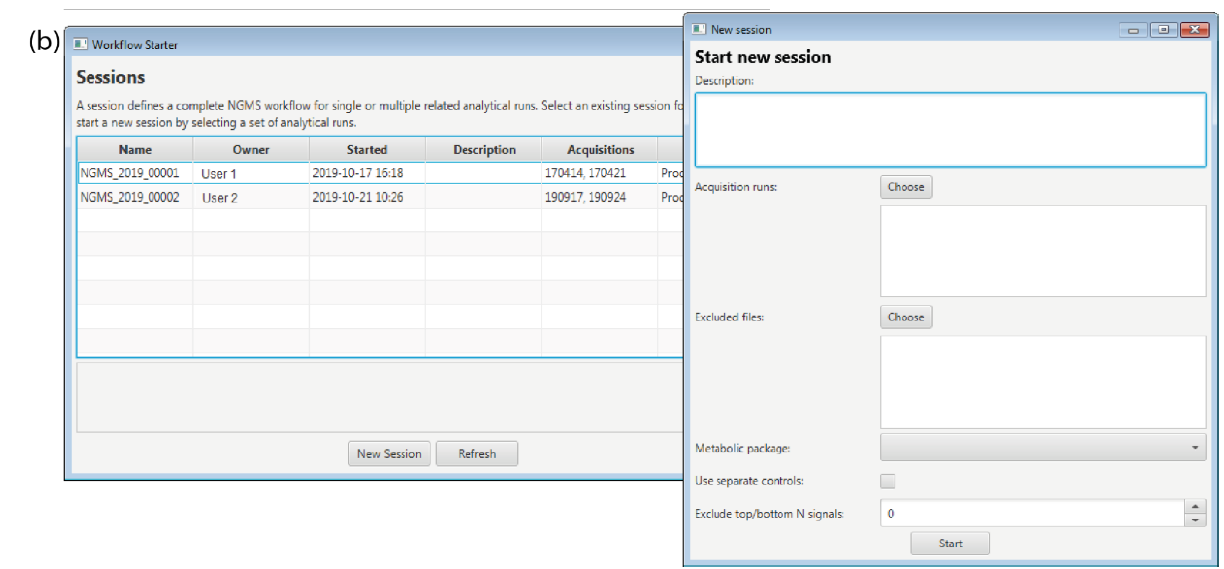
Figure 3. Screenshots of the graphical user interface of the ( a ) Storage tool and the ( b ) Workflow starter.